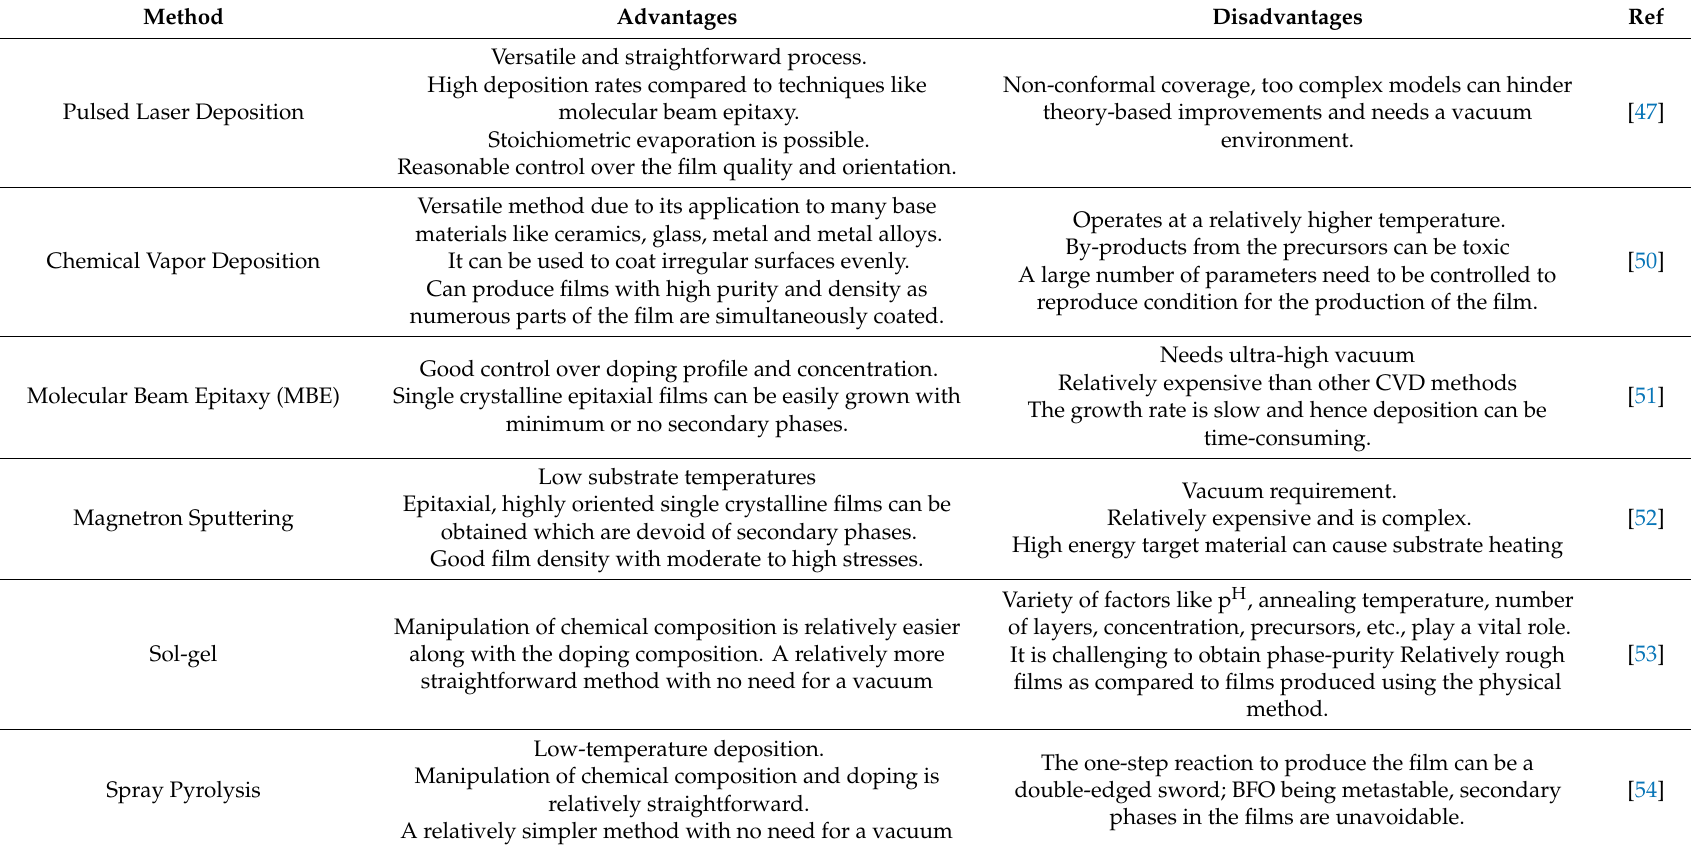
Table 3. Popular methods to produce Bismuth ferrite (BFO) thin